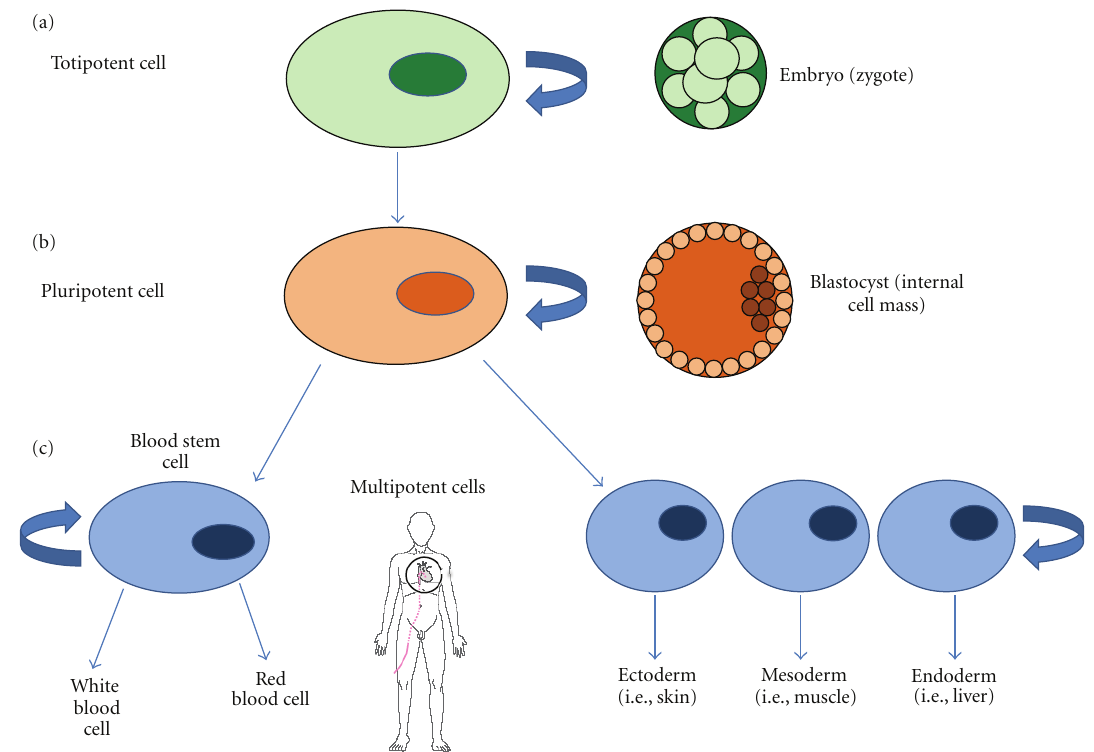
Figure 1: Schematic representation of the functional potency of stem cells. (a) Totipotent cells are present in the embryo until the 8-cell stage. They can generate all cells of the organism and even a whole new individual if provided with appropriate maternal support. (b) Pluripotent cells reside in the internal cell mass of the blastocyst. During the life of the embryo and as tissues di ff erentiate, pluripotency extinguishes. They can di ff erentiate into multiple-cell types representative of all 3 embryonic germ layers. (c) Once the organism is formed, multipotent cells are present in all tissues, committed to ectodermic, mesodermic, or endodermic di ff erentiations. The turning arrow indicates the clonogenic self-renewal capacity of stem